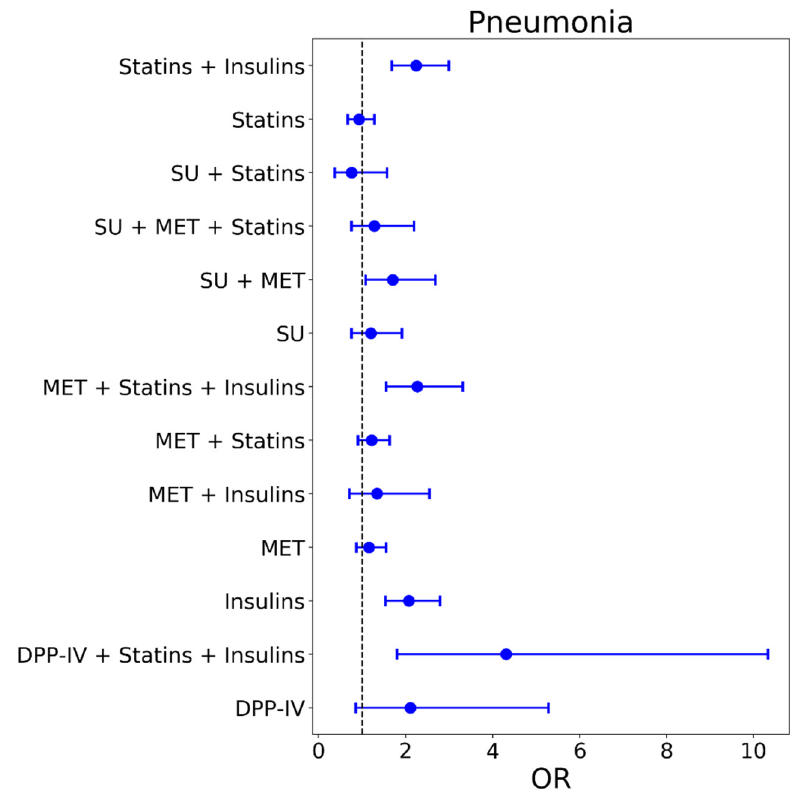
Figure 1. Odds ratios of pneumonia outcome for therapy groups compared to controls.